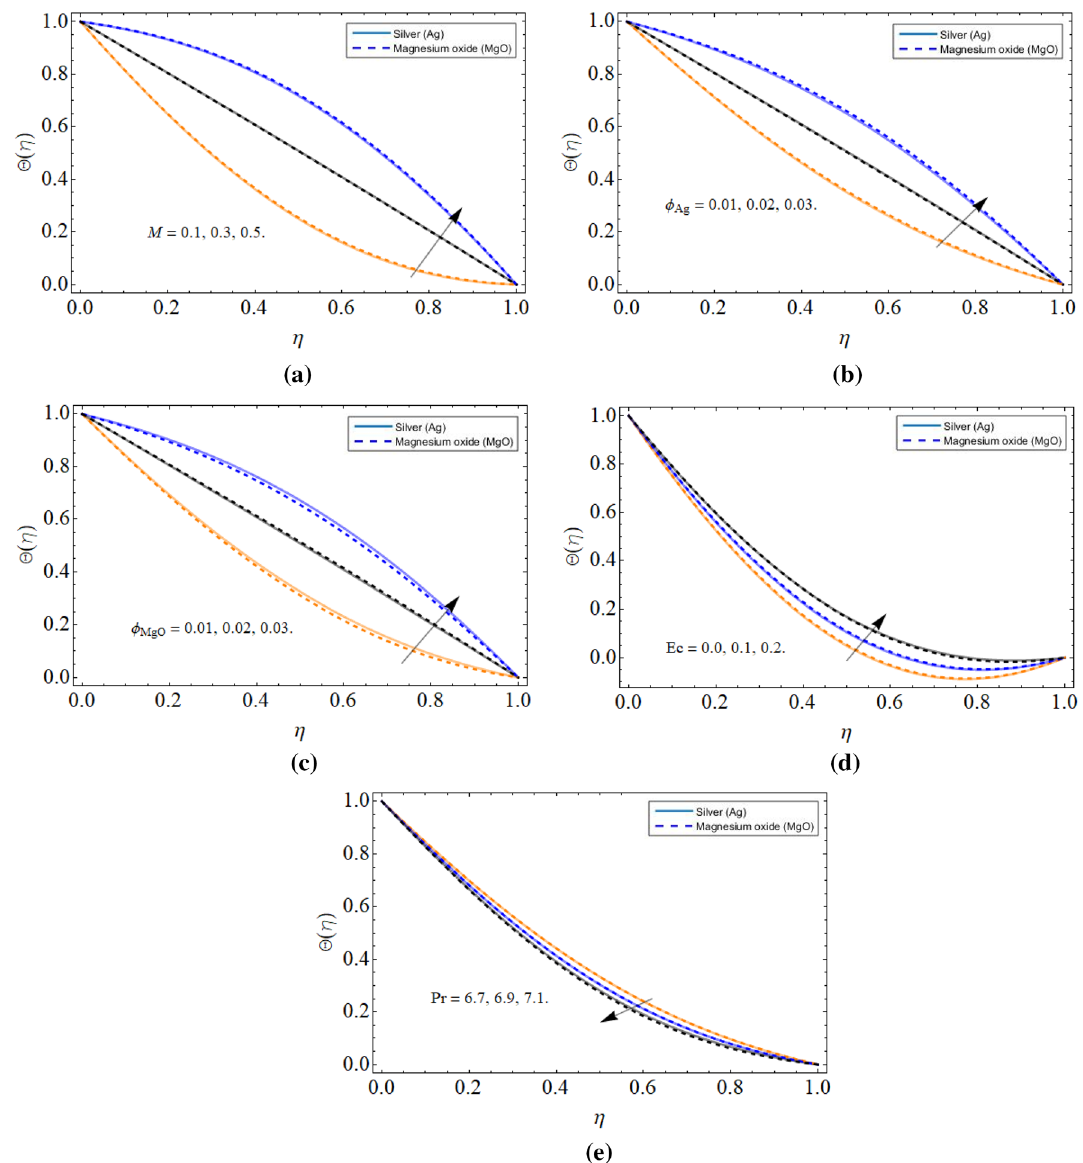
Figure 5. The behavior of thermal energy profile � ( η ) versus ( a ) magnetic field M ( b ) volume friction of silver φ Ag ( c ) volume friction of magnesium oxide φ MgO ( d ) Eckert number Ec ( e ) Prandtl number Pr Figure 6a–d spotted the four different cases between the cone and disk. The rotation of the disk, while keep- ing the cone fixed reduces the energy profile as appeared in Fig. 6a. An opposite scenario has been observed while keeping the disk fixed and spinning cone Fig. 6b. Figure 6c,d revealed that the energy profile reduces with the co-rotation of disk and cone, while enhances with counter-rotation because the opposite direction motion generates resistive force, which encourages fluid temperature �(η) as scrutinized in Fig. 6d. Concentration and motile microorganism profile. Figure 7a–d manifested the behavior of mass transfer profile �(η) and motile microorganism ¯ (cid:31) (η) versus Schmidt number Sc , volume friction of silver φ Ag , Reynold number Re and Peclet number Pe respectively. The Schmidt number upshot diminished the mass transi- tion rate as shown in Fig. 7a. Physically, the molecular diffusion lowers, and kinetic viscosity rises with Schmidt number, that’s why such phenomena have been observed. An opposite scenario is observed against silver nano- particles φ Ag that the mass transference enhances with the upshot of silver nanoparticles as elaborated through Fig. 7b. Figure 7c,d illustrated that the bioconvection Reynold number Re and Peclet number Pe declines the motile microorganism ¯ (cid:31) (η) profile. Because the density of microorganism decreases with the upshot of both Reynold number Re and Peclet number.